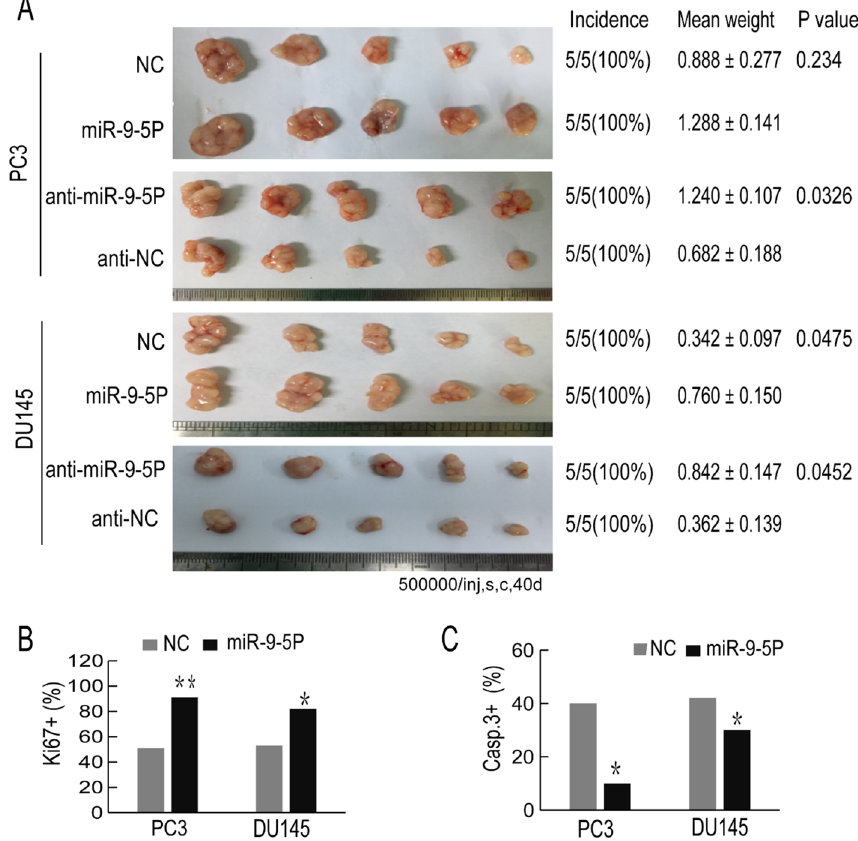
Figure 6. Overexpression of miR-9-5p promotes xenograft tumor growth in vivo. (A) Overexpression or decreased expression of miR-9-5p in PC3 or DU145 cells was generated, after which the transfected cells were subcutaneously injected into BALB/C nude mice. Tumors were harvested and the tumor images is shown on the left of the picture. The incidence (tumors/injections) and weight of the tumors (mean ± S.D.) and the corresponding P values are shown on the right of the picture. (B, C) Representative immunohistochemical (IHC) staining pictures are shown, in which the Ki-67- or Caspase-3-positive cells from the harvested tumor tissues were stained (magnification, × 200). The percentage of Ki67-positive or Caspase-3-positive cells was calculated. All results are represented as the mean ± SEM from three independent assays. * P < 0.05, ** P <